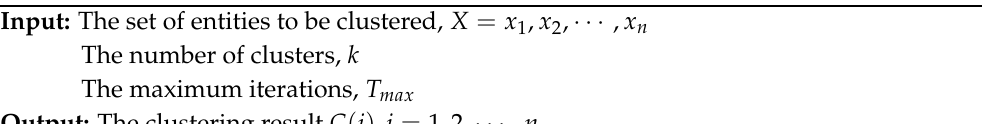
Algorithm 1: K-Means Algorithm for BDs